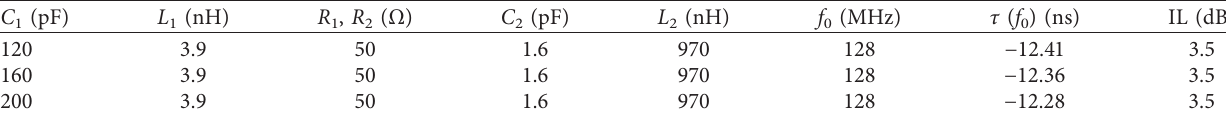
Figure 7: S parameters of the band-stop filter with band-pass negative delay at different C Table 3: Element values and performance indexes of the band-stop filter with different C occurs.